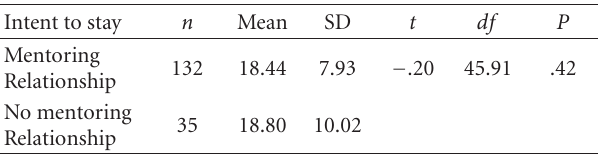
Table 5: Mean scores of intent to stay and t -test comparing mentoring relationship with intent to